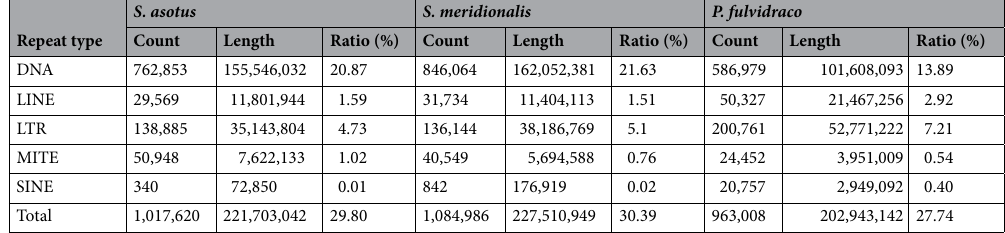
Table 3. The total number (count), total length (in bp) and its ratio account for the whole genome for major repeat elements reside in each of the three genomes including S. asotus , S. meridionalis , and P. fulvidraco